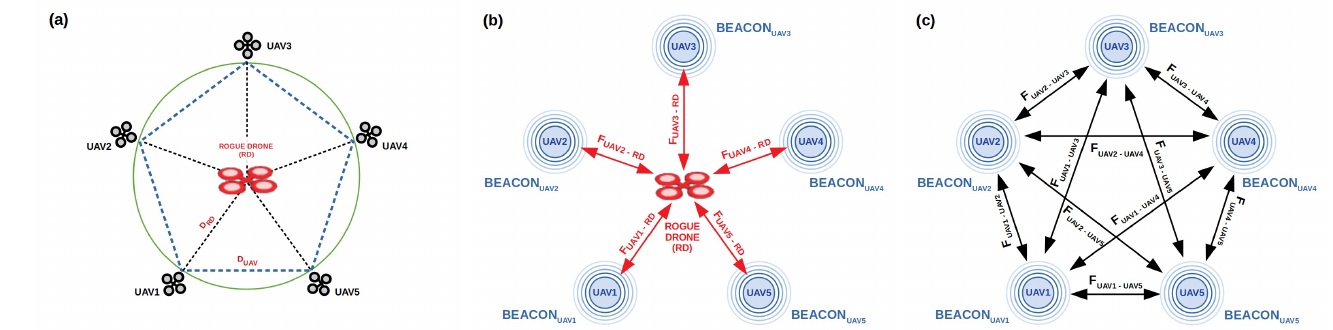
Figure 1. A 2D representation of the 3D formation system. ( a ) Swarm of five drones escorting the rogue drone. ( b ) Attracting/repelling forces between each drone in the swarm and the rogue drone. ( c ) Attracting/repelling forces between